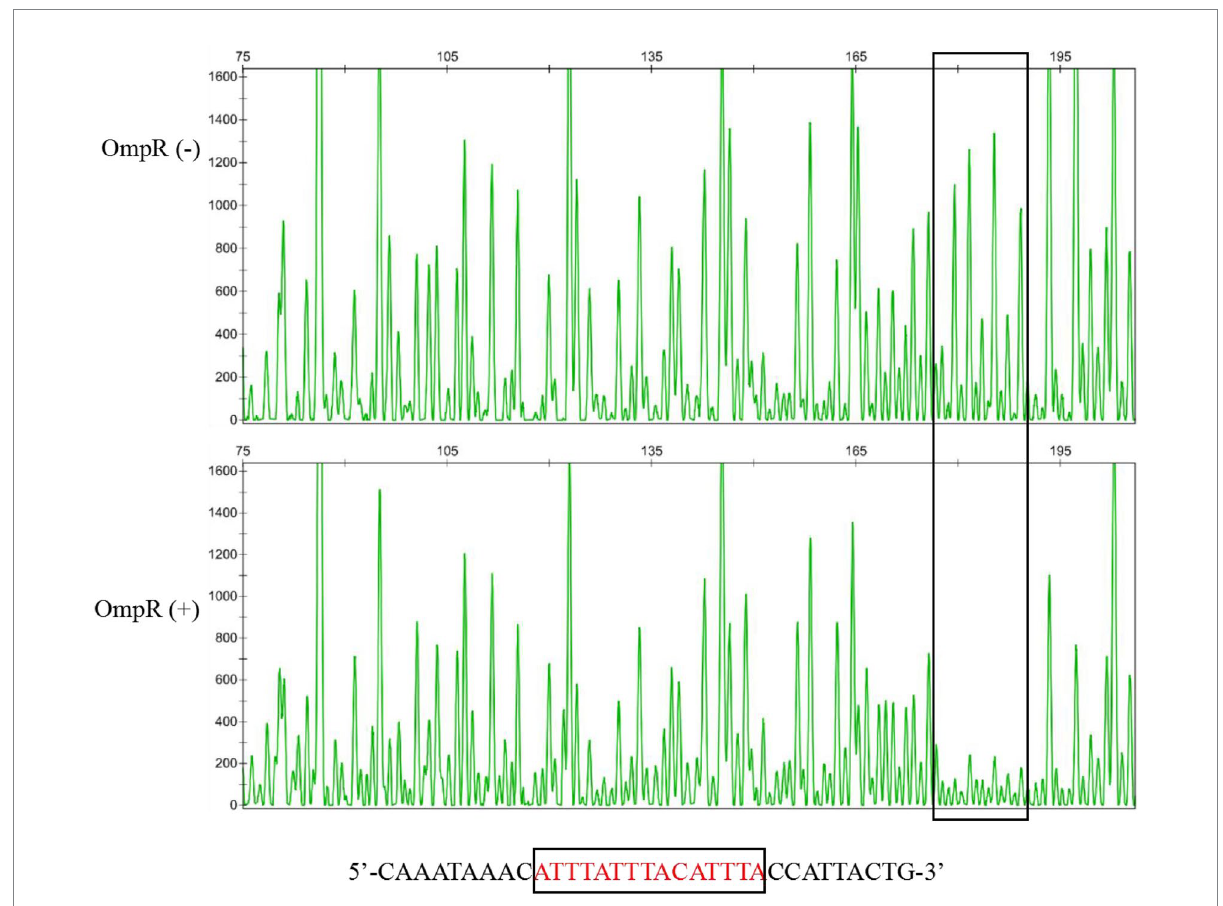
FIGURE 3 Confirmation of the proposed binding sequence of OmpR with the pig cluster promoter by DNaseI foot-printing assay. The OmpR ( − ) group indicates that the promoter probe was not incubated with OmpR protein before treatment with DNase I, and the OmpR (+) group indicates that the promoter probe was incubated with OmpR protein before treatment with DNase